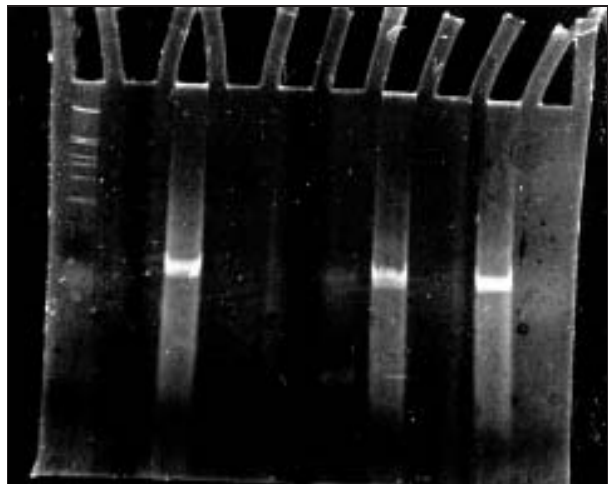
Figure 1) Ethidium bromide-stained polyacrylamide gel of DNA mark- ers (lane 1), polymerase master mix with water (negative control, lane 2) and amplification products of purified DNA of Candida albicans (lane 3), negative control of amplification (amplification without tem- plate) (lane 4), unspiked blood (lane 5), blood spiked with 10